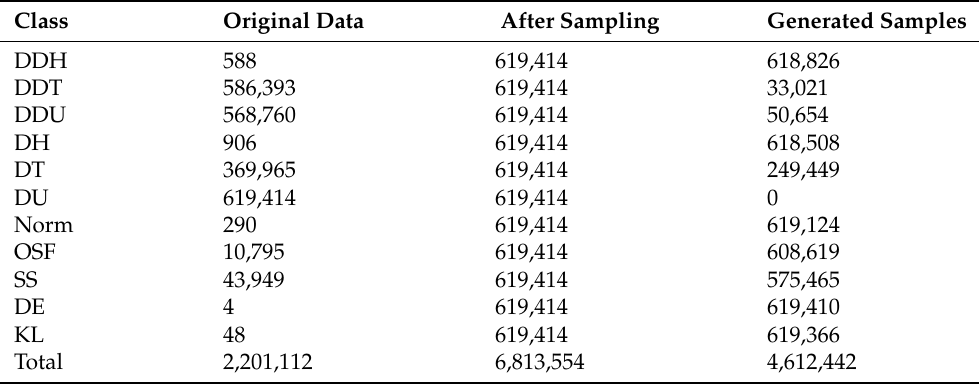
Table 5. Sample distribution of training set for S-DRNN